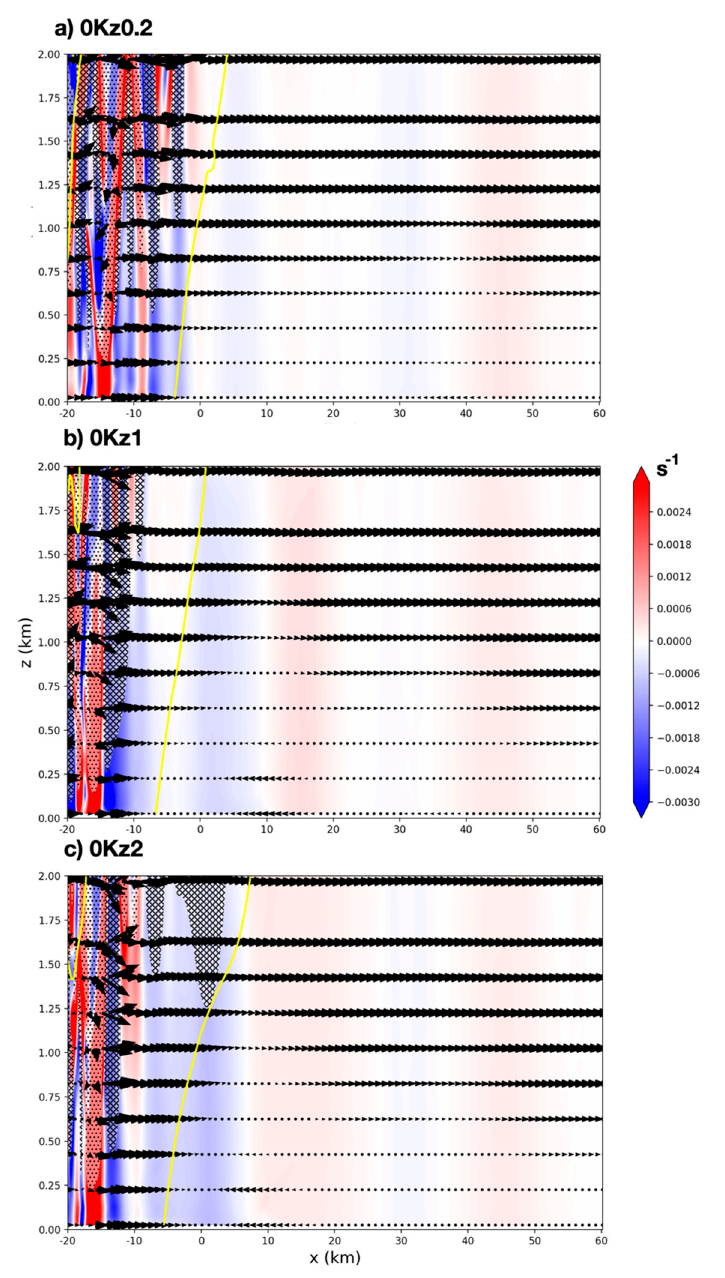
Figure 9. Divergence (colored), wind arrows, and vertical velocity (hatched areas are > 1 m s − 1 and stippled areas are < − 1 m s − 1 ), at t = 145 min in three select simulations. The arrow length is proportional to wind speed. The yellow contour represents the hydrometeor mixing ratio value of 0.02 g kg − 1 .